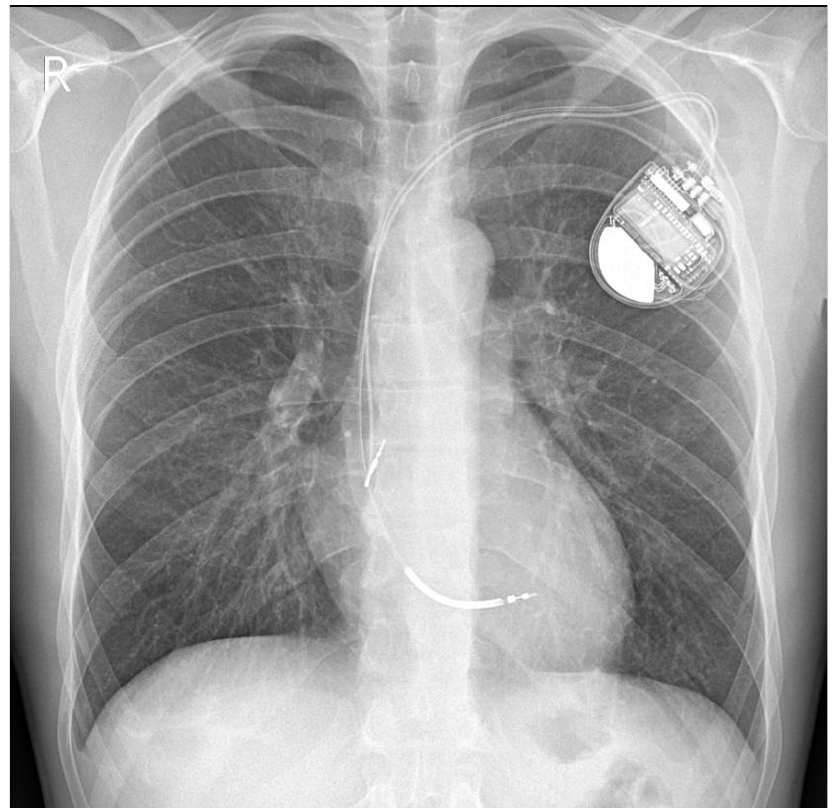
Figure 6. Chest X-ray in the PA projection—condition after implantation of a dual-chamber cardioverter-defibrillator—a single-coil defibrillating electrode with a tip in the middle of the interventricular septum and atrial electrode with a tip in the right atrium appendage. No other abnormalities are seen in the X-ray image.